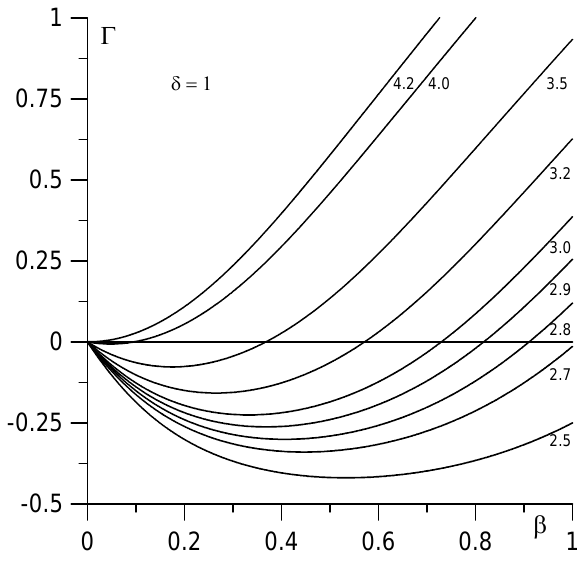
Fig. 5d. The same for δ = 2 . 5 (slightly above the δ 0 value).